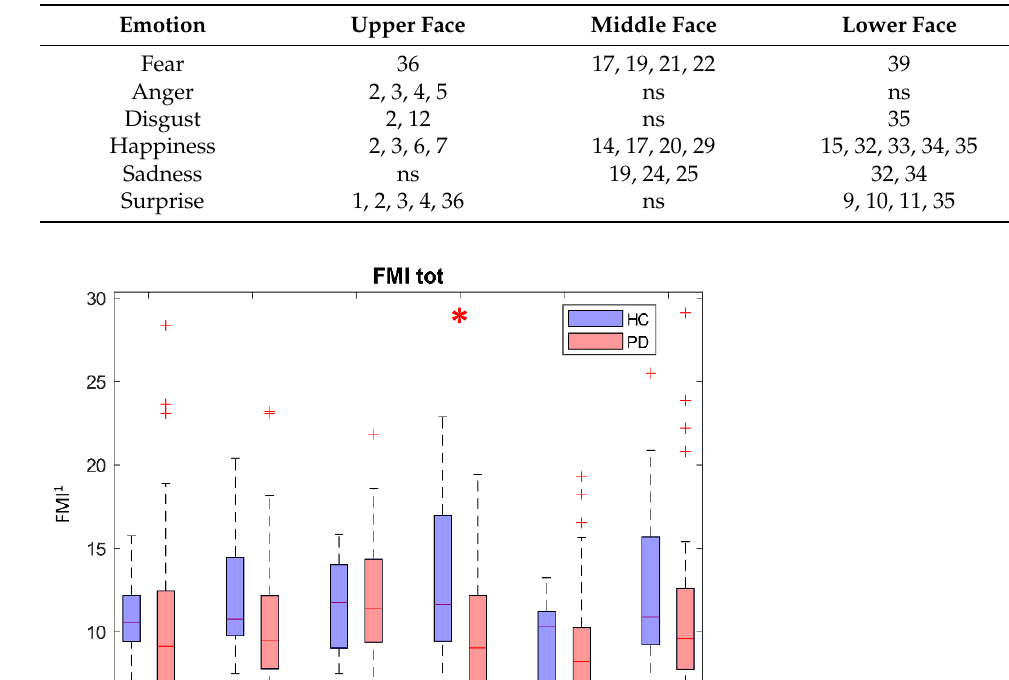
Table 3. Correlation coefficients between UPDRS III, duration, age, and gender values and FMI of each emotion. r = Pearson correlation coefficient, r PB = Point-biserial correlation coefficient, p = p value ( p <